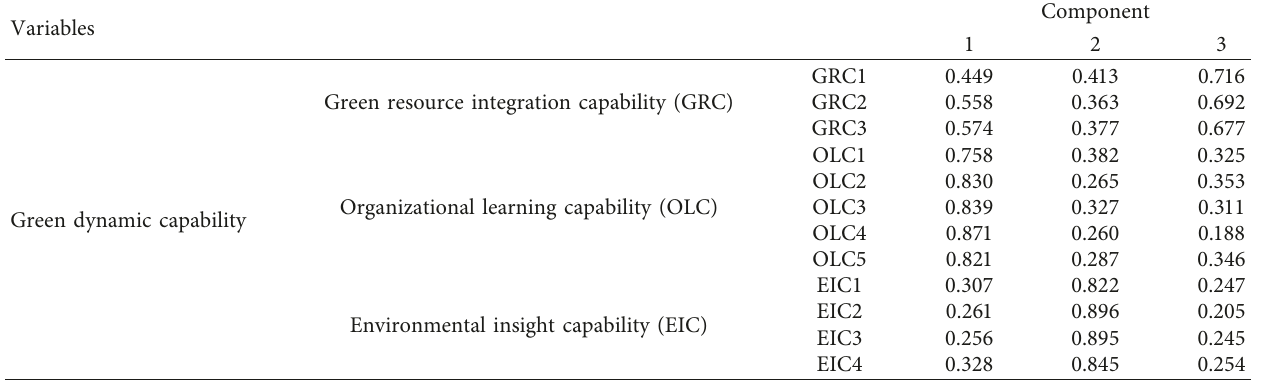
Table 5: Rotated component matrix of green dynamic capability.